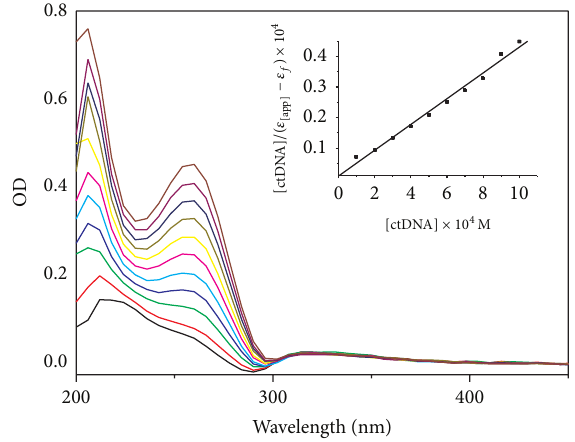
Figure 4: The fluorescence spectra of mixed EB (100 𝜇 M) and ctDNA (220 𝜇 M) in the presence of different concentrations of PMo 10 V 2 in PBS. It shows the fluorescence intensity changes upon increasing concentrations of PMo 10 V 2 ([PMo 10 V 2 ] = 0, 10, 20, 30, 40, 50, 60, 70, 80 𝜇 M). Insert: Stern-Volmer plot of the fluorescence titration data of EB-ctDNA with different concentration of PMo 10 V 2 in